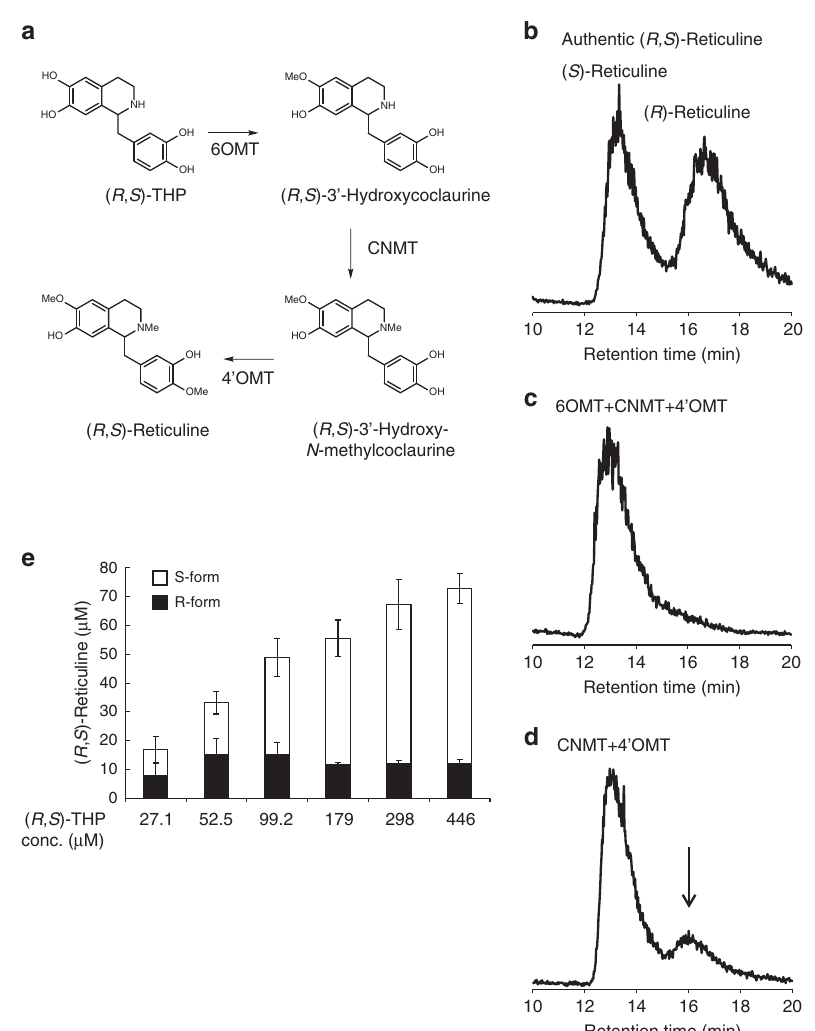
Figure 2 | Total biosynthesis of ( R , S )-reticuline. ( a ) ( R , S )-Reticuline synthetic pathway from ( R , S )-THP. ( b ) The chirality analysis of pure ( R , S )-reticuline. ( c ) The products from the culture of AN1752. ( d ) The products from the culture of AN1600. Experiments in b , c were conducted three times, and same tendency was observed. ( e ) ( R , S )-Reticuline production following the addition of various concentrations of ( R , S )-THP to the AN1600 culture. The error bar indicates the standard deviation of three independent